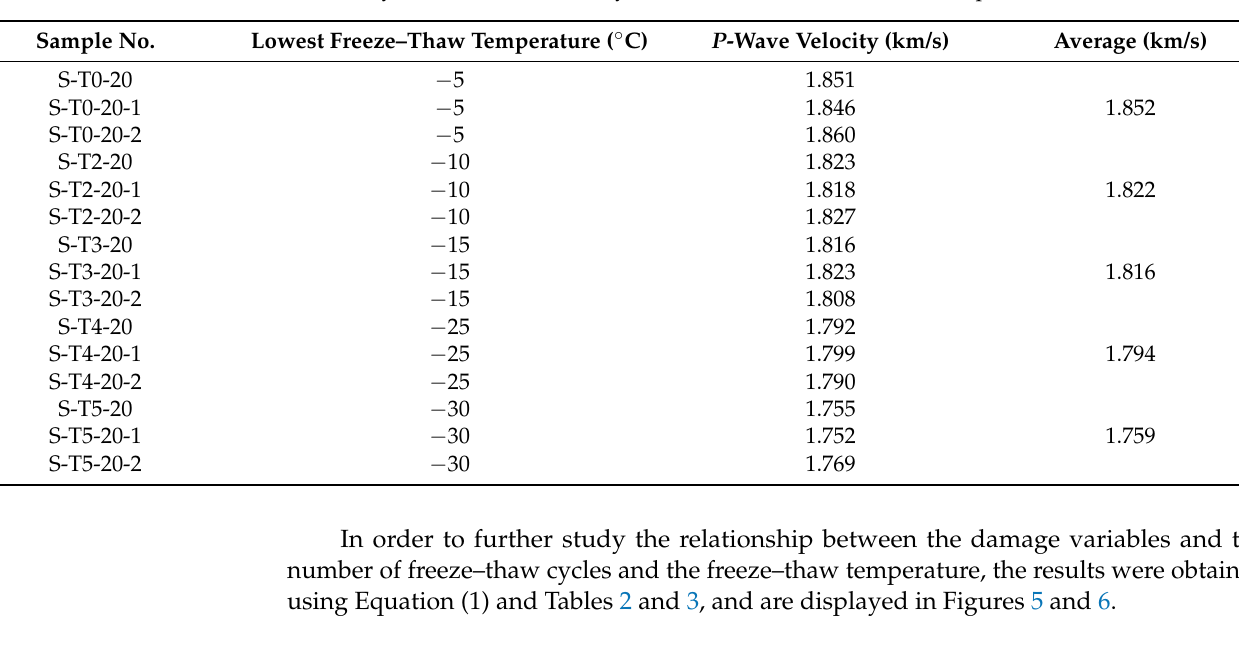
( b ) Figure 6. Freeze–thaw cycles and lowest freeze–thaw temperature versus damage D NT : ( a ) with different freeze–thaw cycles ( T = − 20 °C); ( b ) with different lowest freeze–thaw temperatures ( N = 20). According to Figure 4, the relationship between the P-wave velocity and the number of freeze–thaw cycles under the condition of the lowest freeze–thaw temperature of − 20 °C was found to be